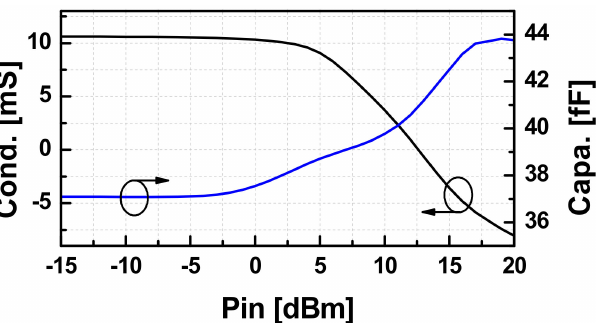
Figure 5. The HBSP-extracted effective capacitance ( C ccp ) and negative conductance ( G ccp ) of a